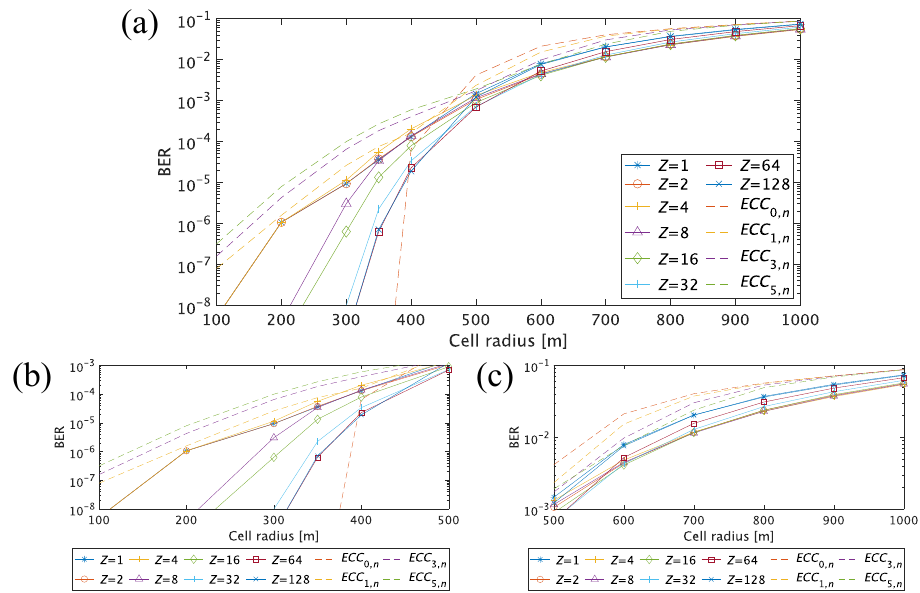
Figure 10. ( a ) BER comparison with the different number of thresholds 2 Z + 1 related to the laser chaos decision-maker. (ECC is set to ECC τ 7 for Z = 1, . . . ,128. Z is set to 1 for ECC 0, n , ECC 1, n , ECC 3, n , ECC 5, n ). ( b ) Magnified view of ( a ) with respect to smaller cell radii; ( c ) magnified view of ( a ) with respect to smaller cell